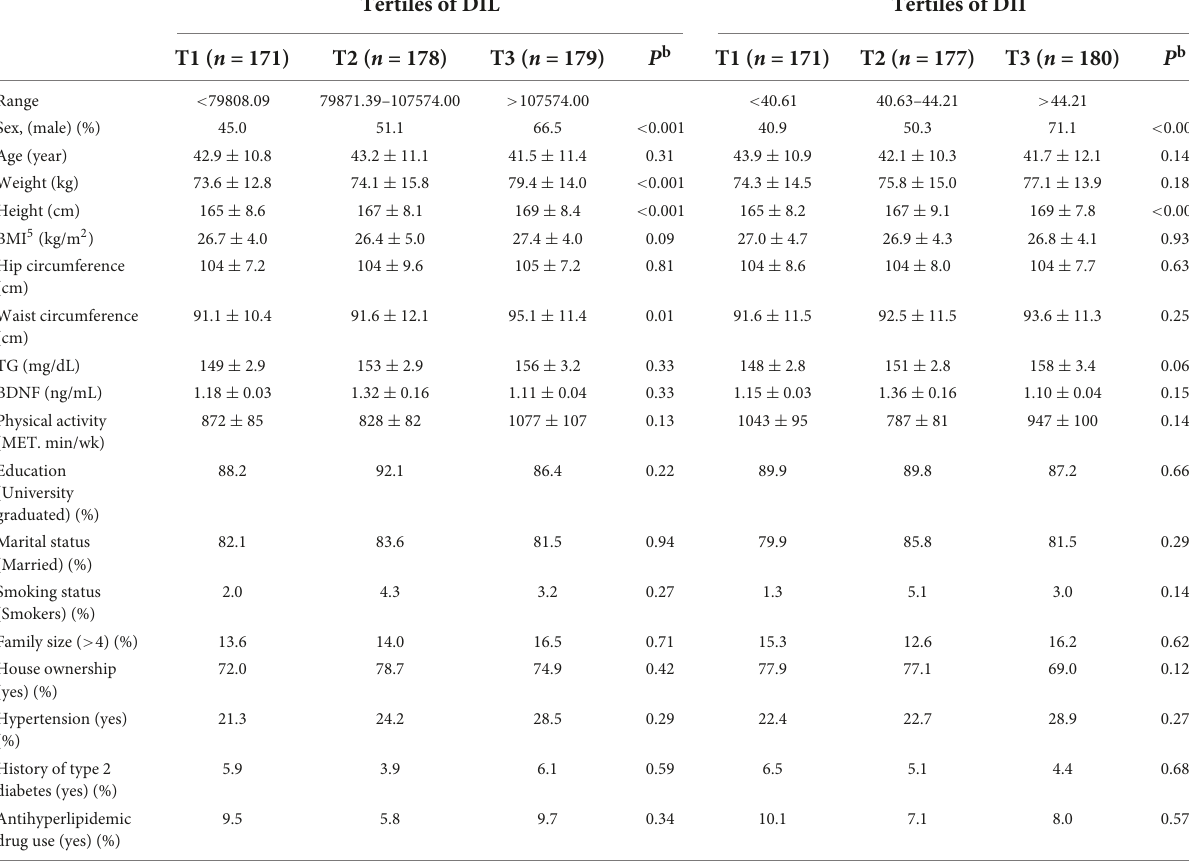
TABLE 1 General characteristics and cardiometabolic factors of study participants across tertiles of DIL and DII a . Tertiles of DIL Tertiles of